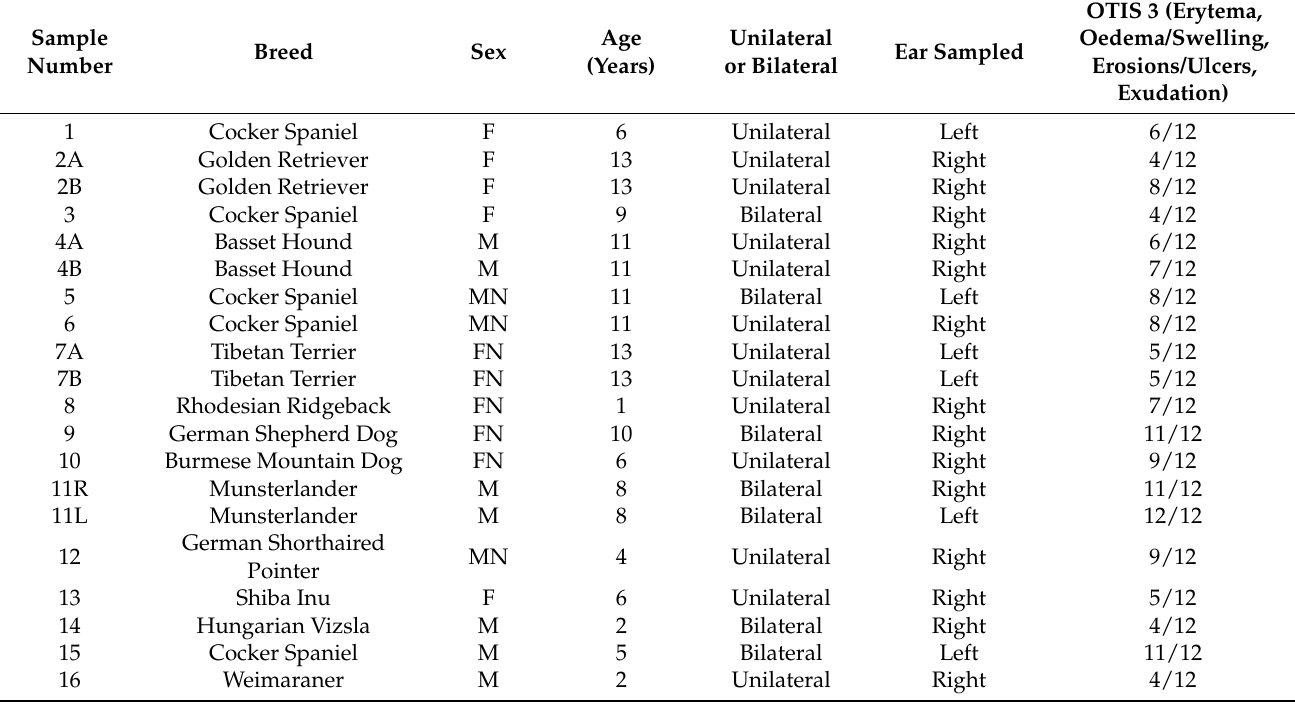
Table 1. Signalment and clinical data of 20 dogs with suppurative otitis externa.